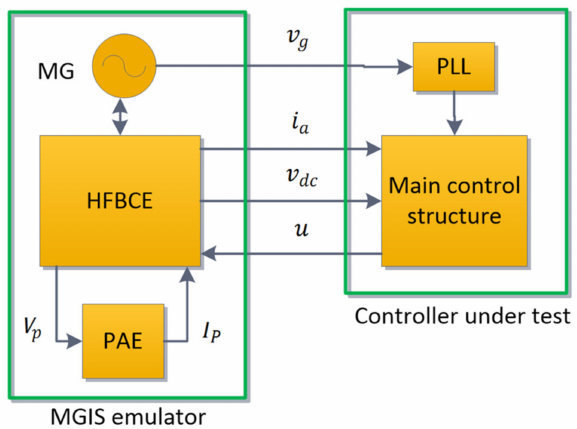
Figure 8. C-HIL platform